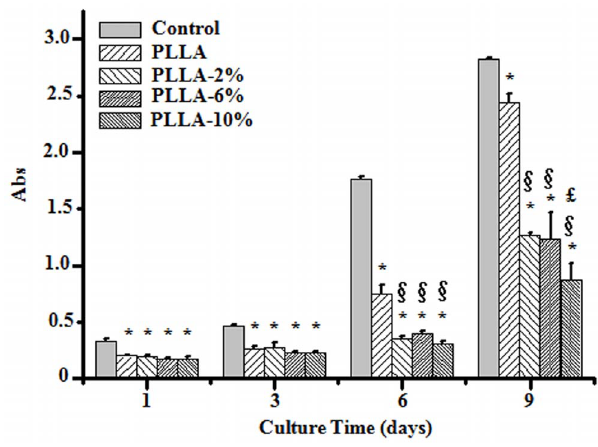
Figure 7. CCK-8 assay of HSFs growth after 1, 3, 6 and 9 d culture. TCP was set as control. *P , 0.05 compared with control. 1 P , 0.05 compared with PLLA. £ P , 0.05 compared with PLLA-2% and PLLA-6%.